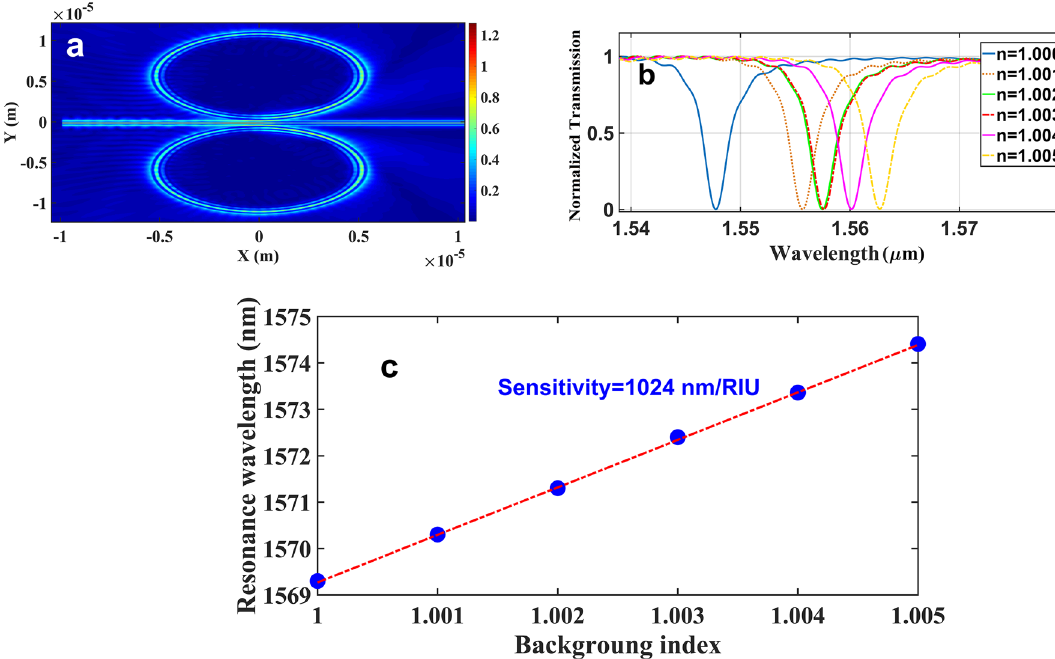
Figure 9. ( a ) The electric field mode profile propagating via the ICCRR system. ( b ) The wavelength shift in resonance peaks for different background indices ( c ) sensing line for ICCRR system.